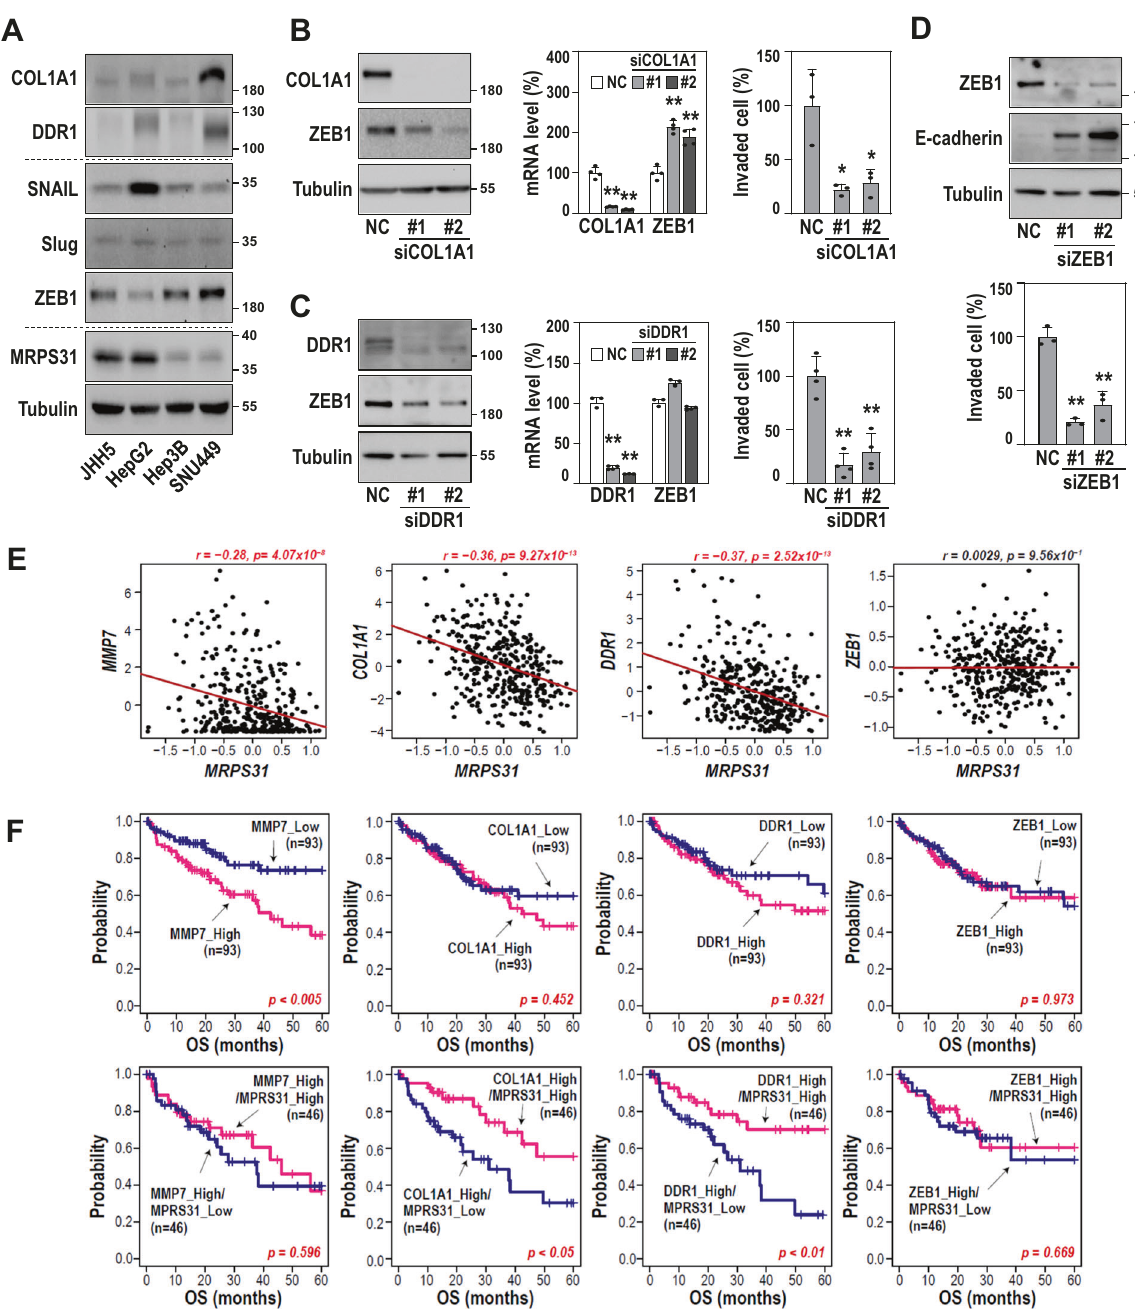
Fig. 7 COL1A1 is a key player of liver cancer cell invasiveness via ZEB1-mediated EMT. A Western blots. B – D SNU449 cells were transfected with siRNAs against COL1A1 (B) , DDR1 (C) , and ZEB1 (D) . B, C Western blots (left), qRT-PCR (middle, N = 4), and cell invasiveness [right, N = 3 for ( B ) and N = 4 for ( C )]. * p < 0.05 and ** p < 0.01 vs. siNC. D Western blots (top) and cell invasiveness (bottom, N = 3). ** p < 0.01 vs. siNC. E Scatter plots of the associations of MRPS31 expression with the indicated genes. The statistical r and p values by Pearson ’ s product-moment correlation test are depicted. F KM curves with OS. TCGA-LIHC samples were strati fi ed into high or low expression group (upper or lower quartile) of the indicated genes (top). The high expression groups of the individual genes were further strati fi ed into MRPS31 high or low expression group by using median values (bottom). The statistical p values by Cox-Mantel log-rank test are